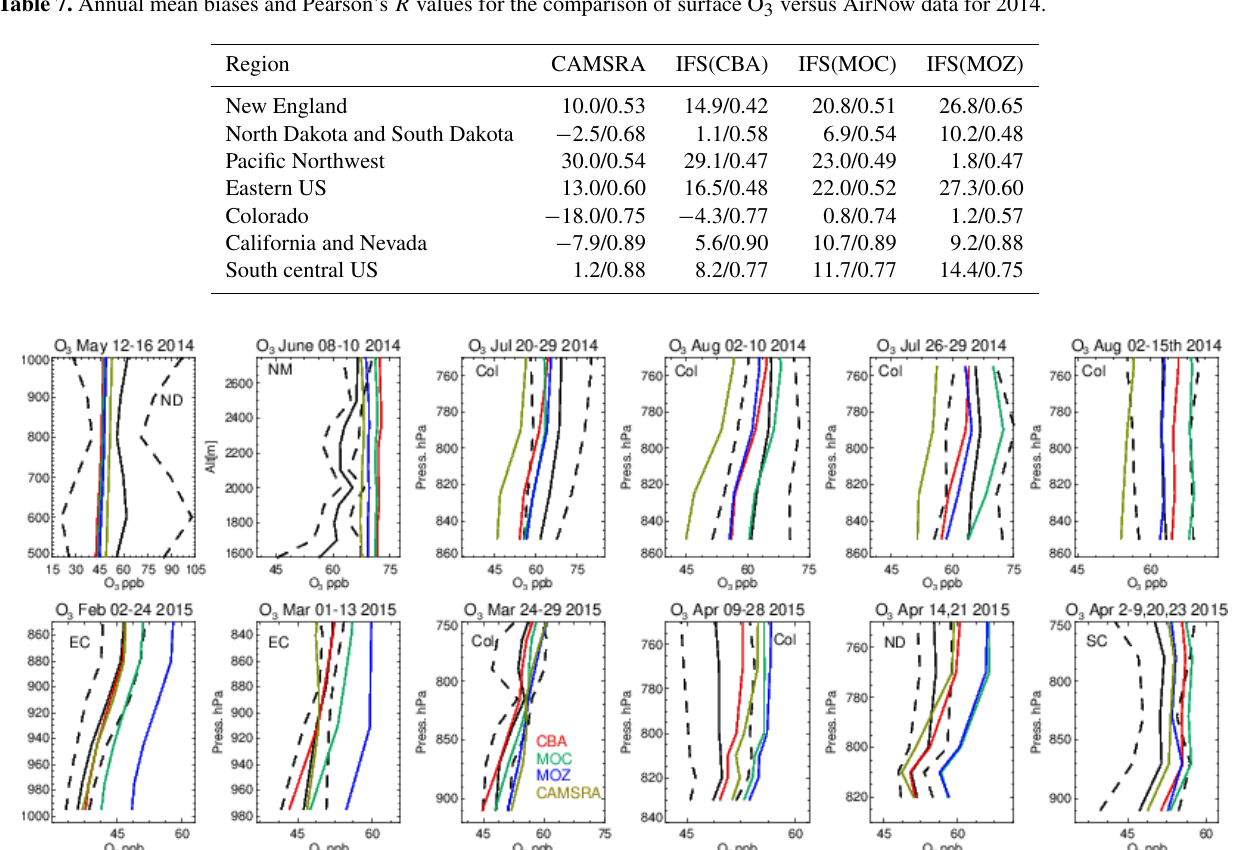
Figure 6. Comparisons of lower tropospheric O 3 profiles for 2014/2015 against composites of aircraft measurements for the regional domains shown in Fig. 1. The 1 σ standard deviation of the mean for the observational values are shown as the dashed line. Campaigns shown (top left to bottom right) are TOPDOWN, DISCOVER-AQ, FRAPPE, WINTER and